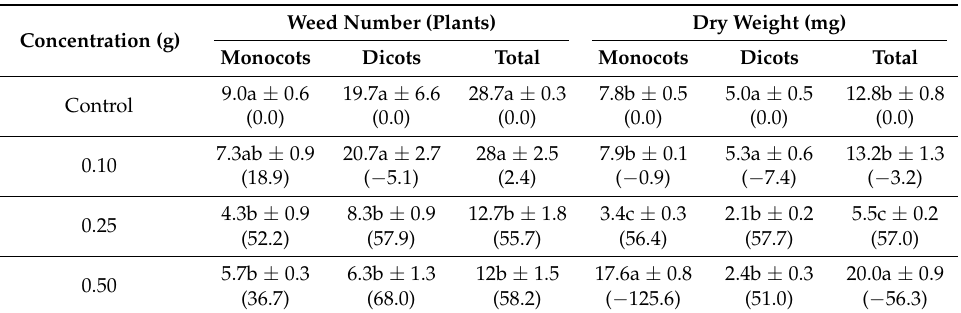
Table 5. Effects of C. crenata dried leaf powder on plant number and dry weight of weeds in the natural soil in laboratorial